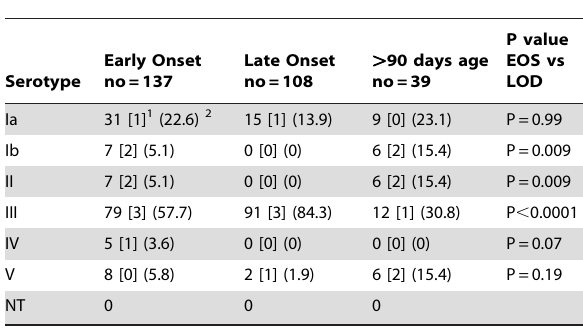
1 Figure in squared parenthesis indicates number of isolates which were serologically non-reactive but typed by PCR. 2 Figure in rounded parenthesis is a percentage.